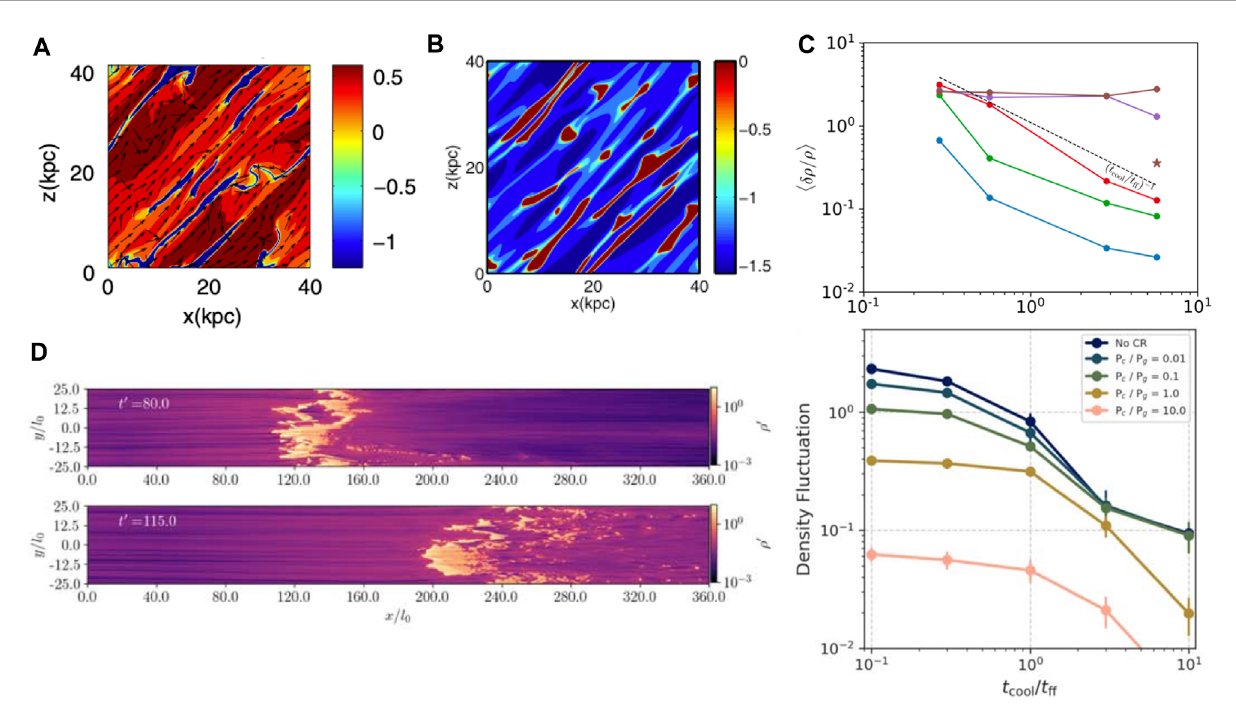
FIGURE 2 (A) Contour plots of log 10 ( T ) where T is the gas temperature for the non-linear stage in a MHD simulation (black arrows show magnetic field lines) with anisotropic thermal conduction (Sharma et al., 2010). The condensed gas is compressed in the cross-field direction while thermal conduction allows for the elongation along the field. (B) Contour plots of log 10 ( p cr / p g ) , the ratio of cosmic ray pressure to gas pressure, showing extension in the size of cold gas dominated by CR pressure. (C) The upper panel shows the scaling of growth rate of TI with plasma β and t cool / t ff , where blue shows the largest β and red, the smallest, and brown and purple show the cases with the galactic cooling function instead of cluster cooling function (Ji et al., 2018). The lower panel shows the same scaling with β instead of p cr / p g (Butsky et al., 2020). (D) Acceleration of cold clouds (here, the gas density is plotted) by CRs (Huang et al.,